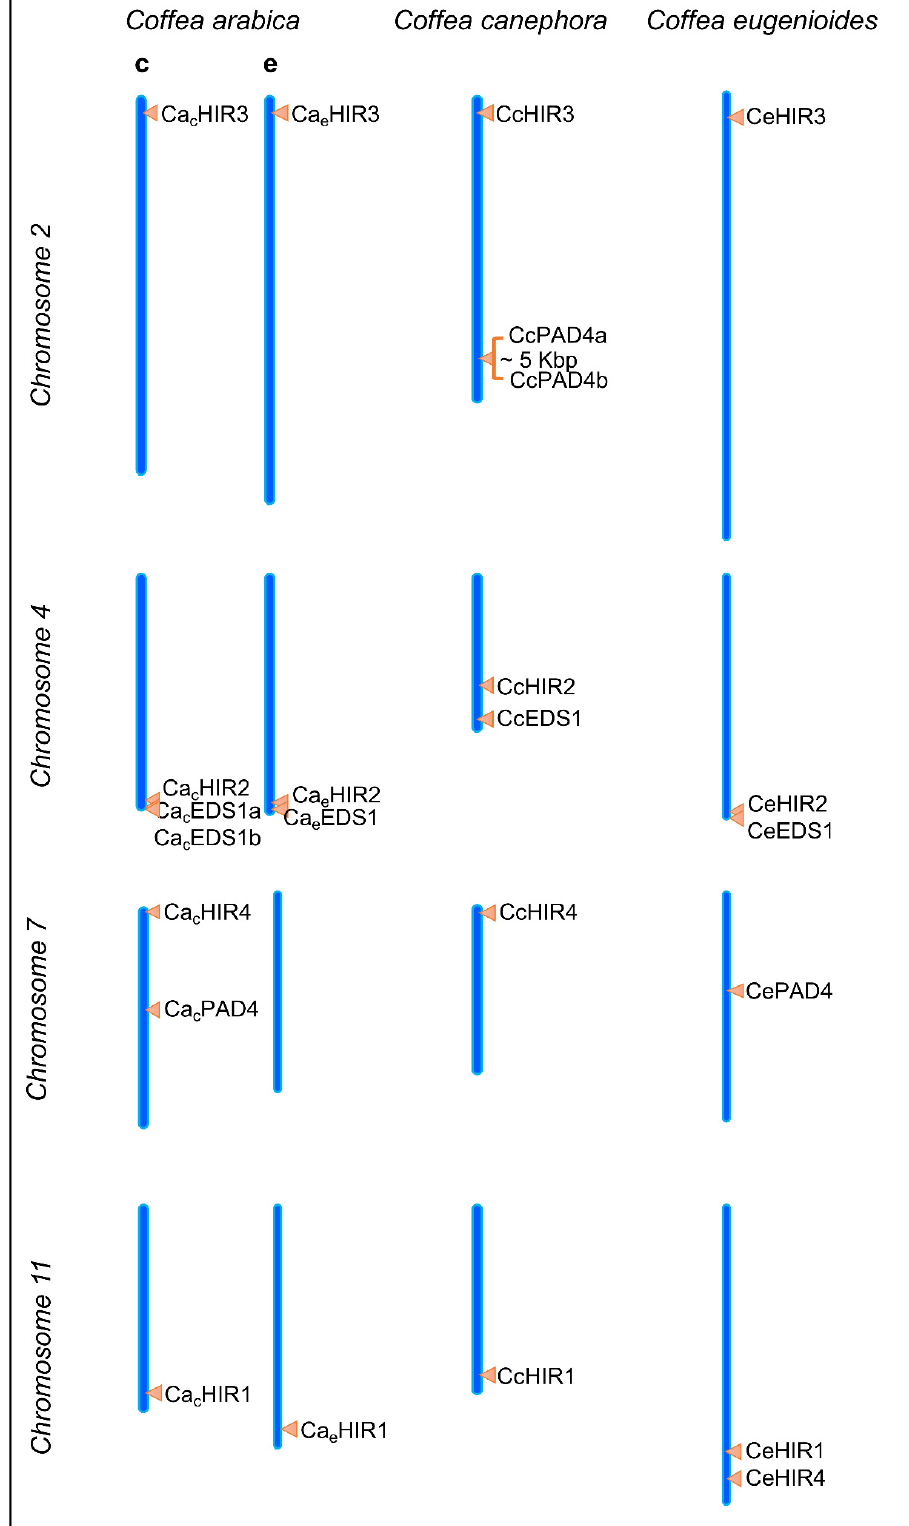
Figure 3. Mapping of HIR , EDS1 and PAD4 genes on chromosomes of Coffea arabica , C. canephora and C. eugenioides genomes. C. arabica genome is divided in chromosomes from the C. canephora parent identified with a c, and chromosomes from the C. eugenioides parent identified with an e. On top of each chromosome is indicated its number.